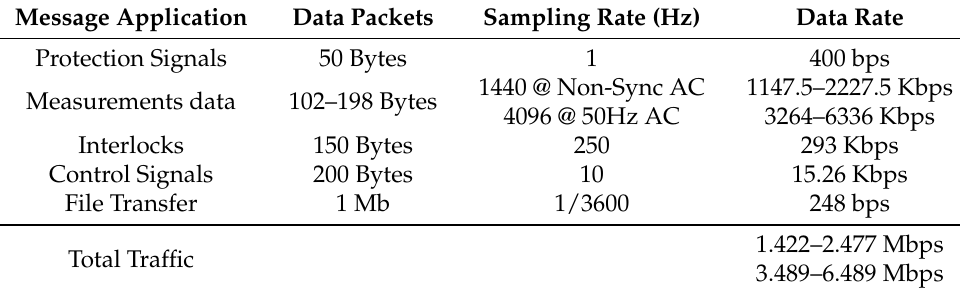
Table 8. Data rate per message application from AC substations based on